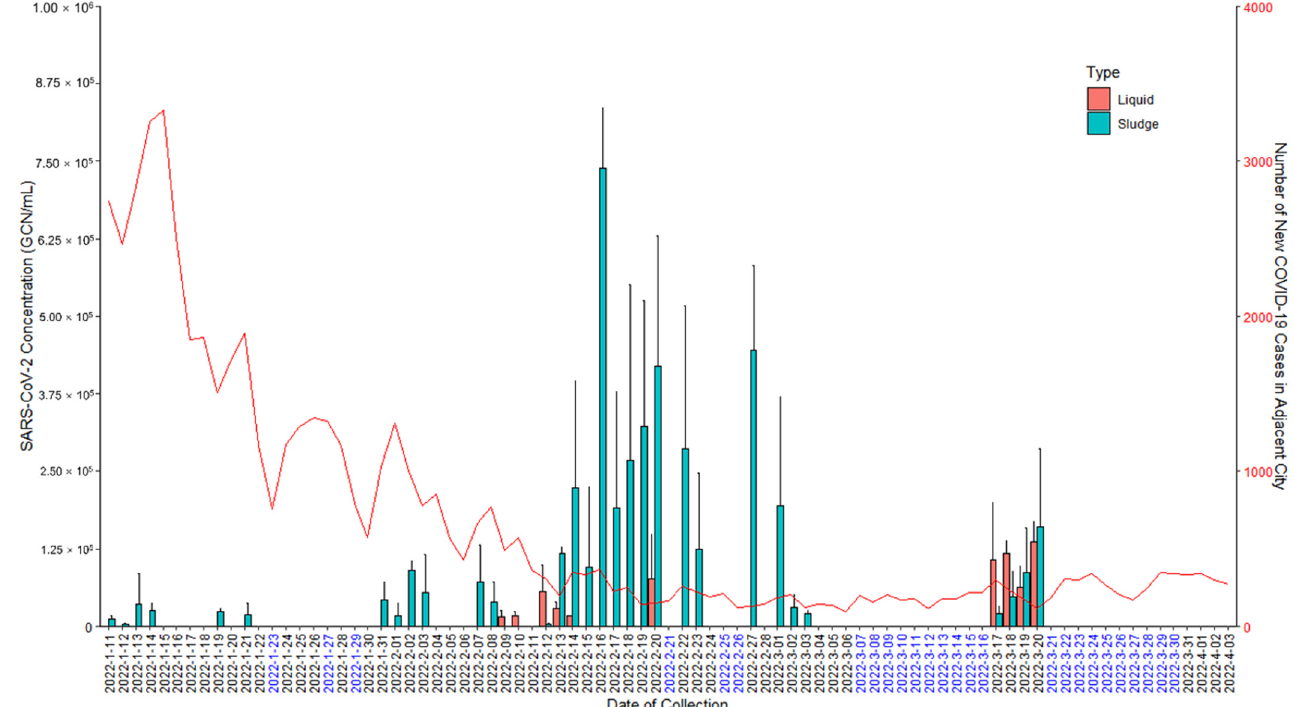
Figure 1. SARS-CoV-2 concentration in the liquid fraction (pink bar) and sludge fraction (green bar) of the tank wastewater from the meat processing plant from 11 January 2022 to 3 April 2022. The dates where wastewater was not collected are marked in blue. SARS-CoV-2 quantification results were obtained from qRT-PCR analysis with conversion from Ct values to GCN/mL based on the standard curve. The number of new clinically diagnosed COVID-19 cases on each date in the adjacent city area during the wastewater collection period is shown by the red curve.